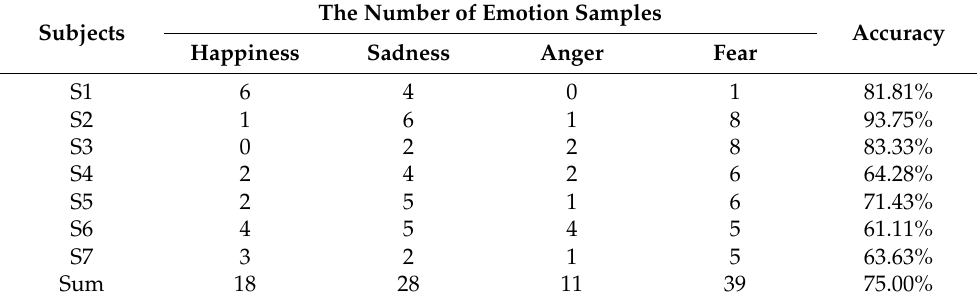
Table 6. The Accuracy of Each Subject in the Test